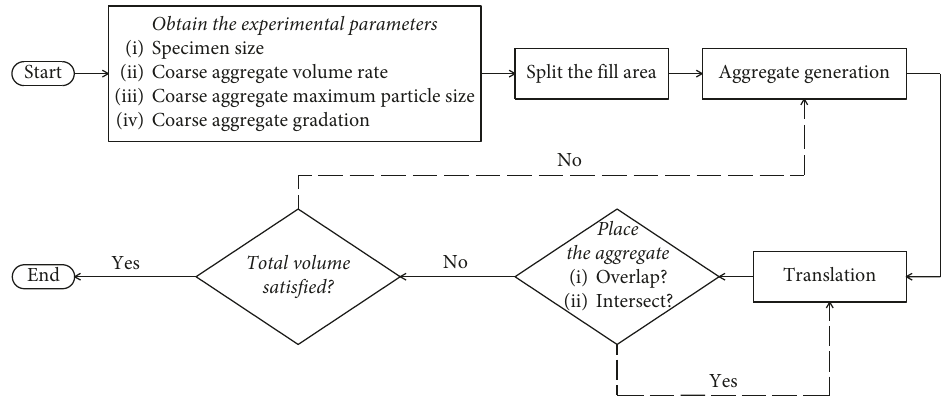
Figure 3: Flow chart of random aggregate